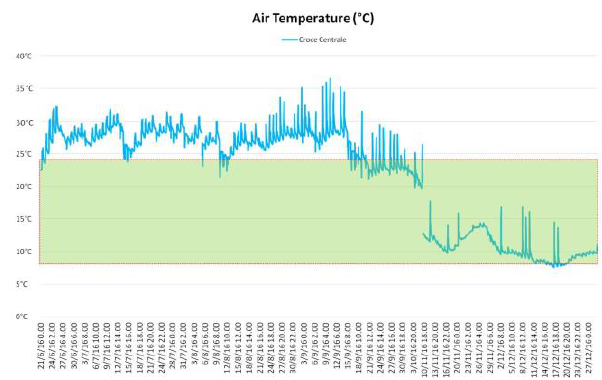
Figure 4. Air Temperature Trend and HMR (T) Range, Room (1) Croce Centrale